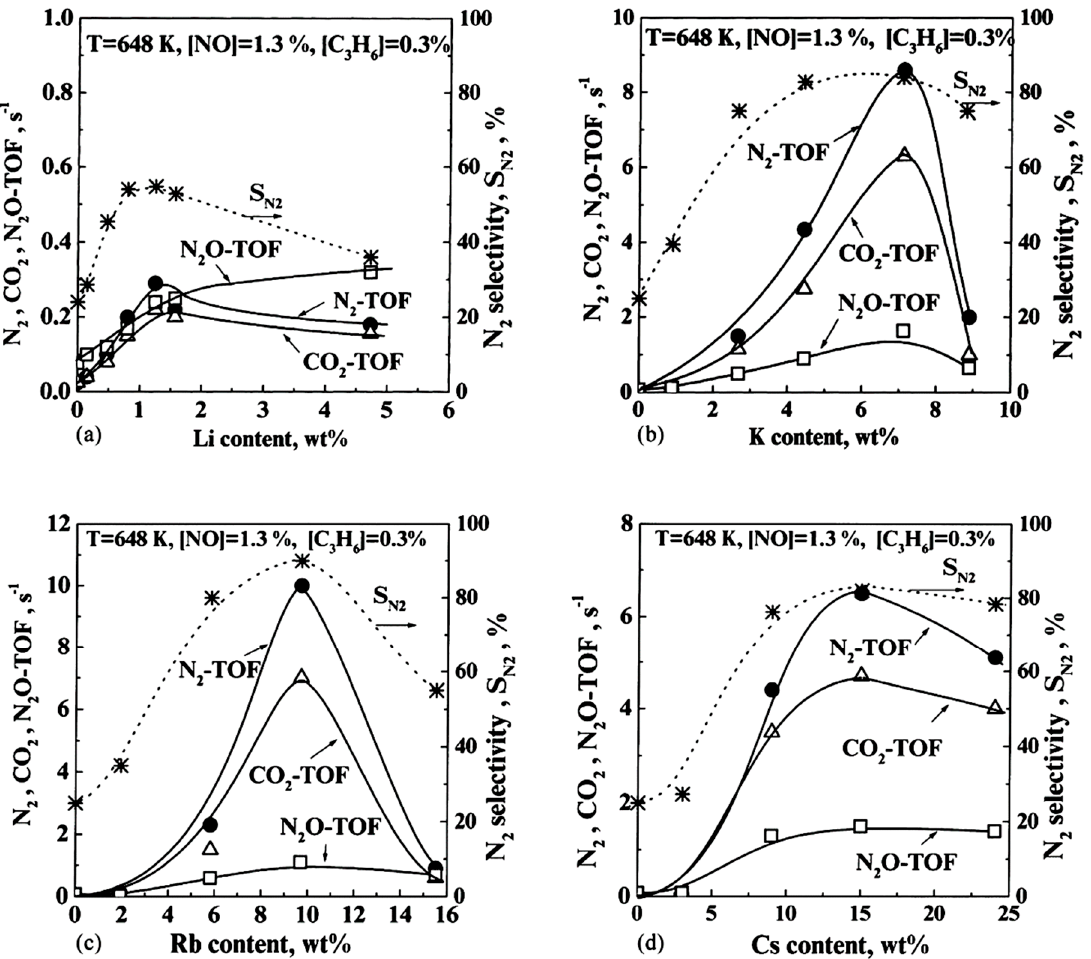
Figure 12. The effect of Li ( a ), K ( b ), Rb ( c ) and Cs ( d ) content of 0.5wt%Pt/ γ -Al 2 O 3 catalyst on the turnover (TOF) formation rates of N 2 , CO 2 and N 2 O and on N 2 -selectivity. Conditions: T = 375 °C, [NO] = 1.3%, [C 3 H 6 ] = 0.3% (Reprinted with permission from Ref. [61]; Copyright 2001, Elsevier).